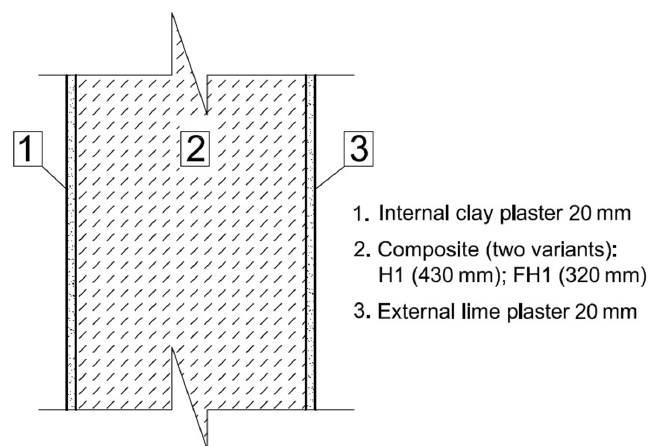
Figure 5. Schematic views of external wall in H1 and FH1 technology.